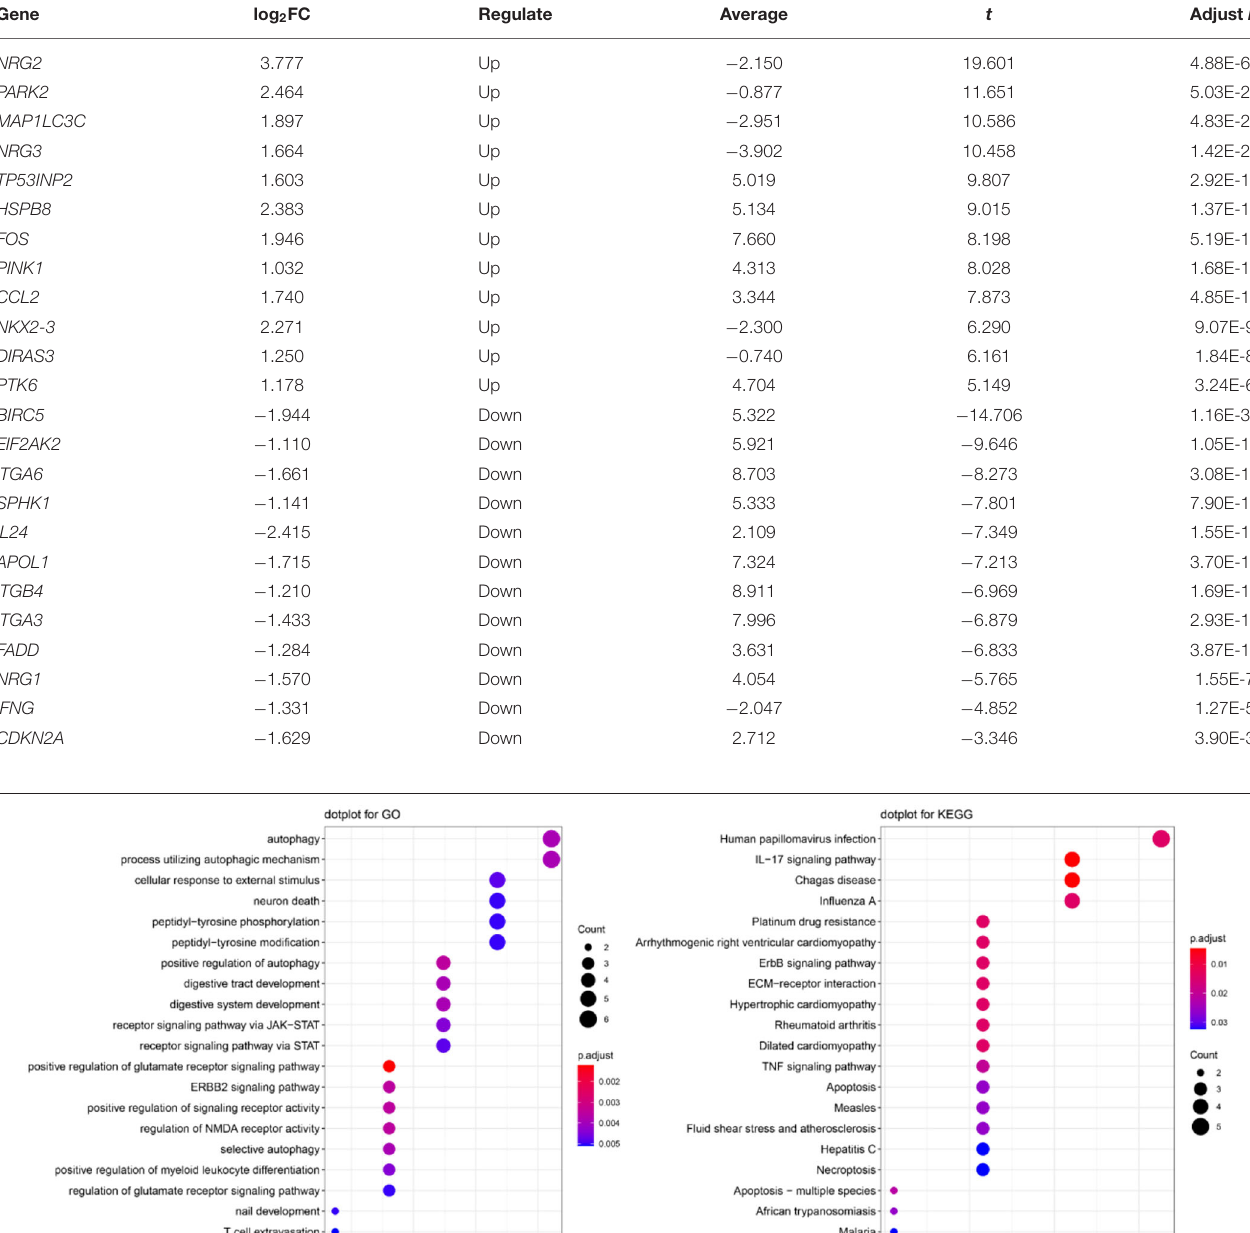
TABLE 2 | A total of 24 autophagy-related genes identified in TCGA data set. Gene